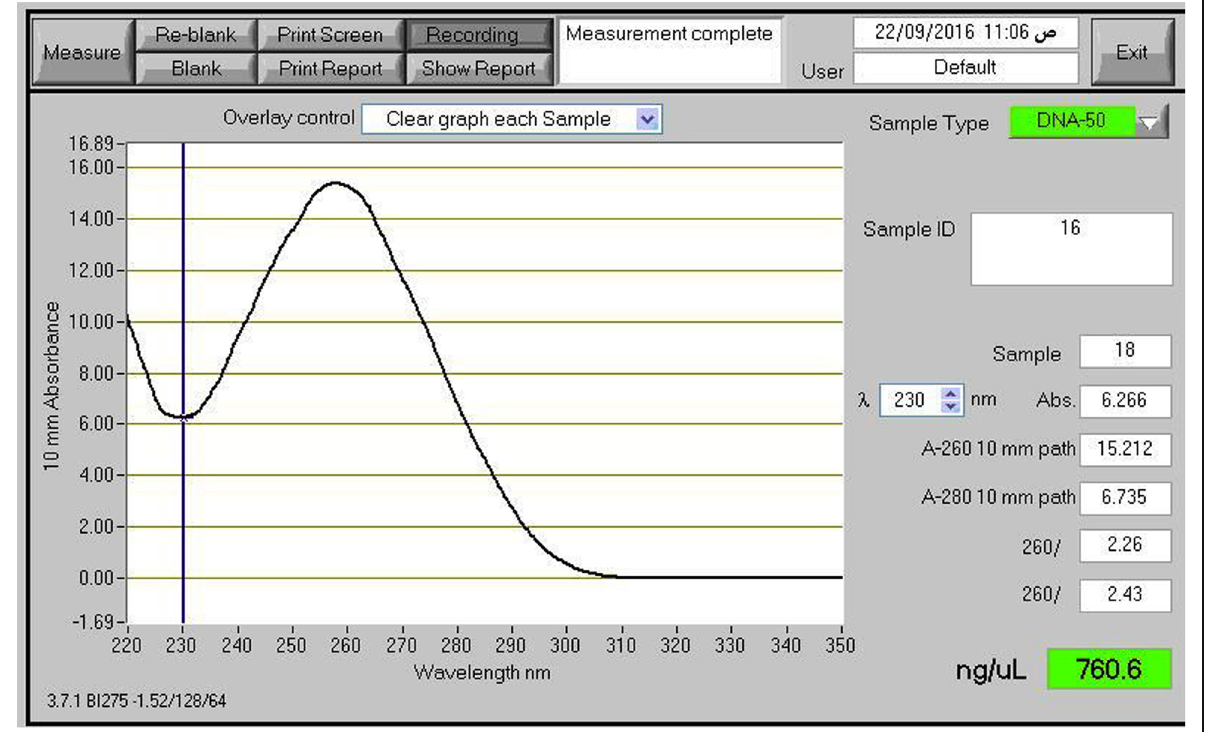
Fig. 2 NanoDrop measurement profile. NanoDrop measurement profile of the extracted genomic DNA from the Glycine max sample using the modified protocol